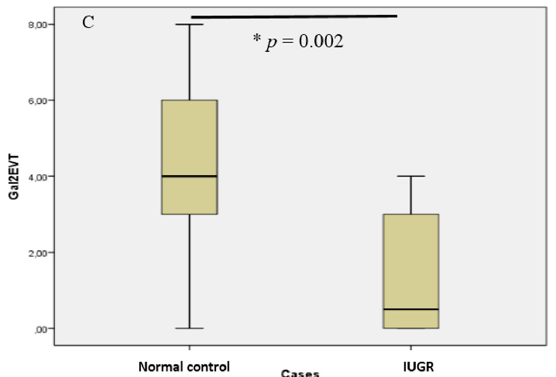
Figure 3. In extravillous trophoblasts, gal-2 expression appeared also to be decreased in IUGR placentas ( A ) compared to control placentas ( B ); Immunostaining revealed a statistically-significant four-fold decrease (* p = 0.002) in IUGR cases in comparison to control placentas, as shown in the